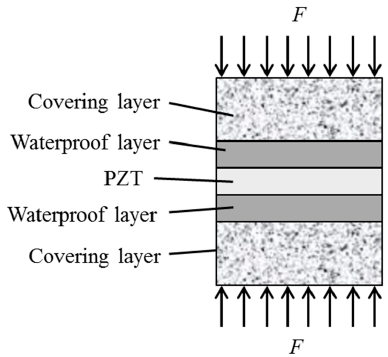
Figure 1. Schematic of the embeddable Lead Zirconate Titanate (PZT) transducer.